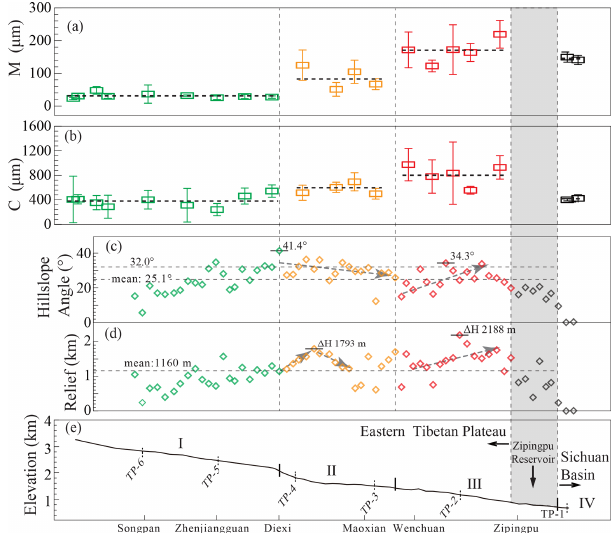
Figure 7. Variation characteristics of (a) M and (b) C values of the grain-size index. (c) Riverbed base level and the position of the cross-section of the upper Min River (Zhang et al., 2005). (d) Hills- lope angle and (e) local relief along the upper Min River. A 4 × 4km grid was delineated along the upper Min River ( ∼ 260km). The highest ridgeline and riverbed height in the grid were extracted from a digital elevation model (DEM) map, and the local relief was then obtained by calculating the highest ridgeline minus the riverbed height. The hillslope angle was obtained by solving for tan (local relief / slope